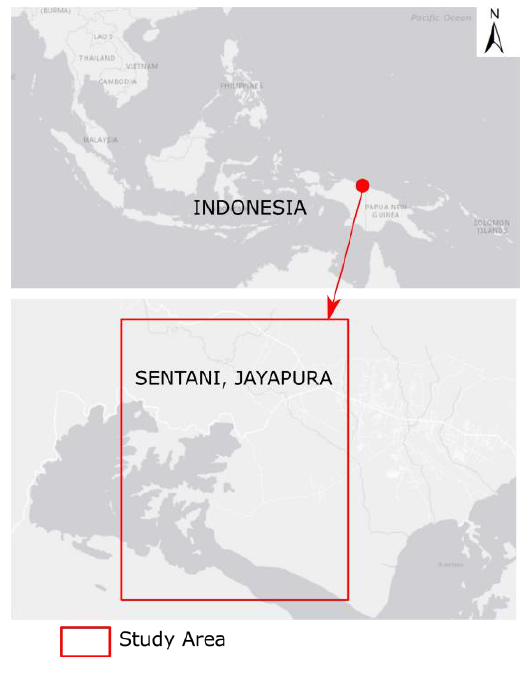
Figure 1. Study area used in this